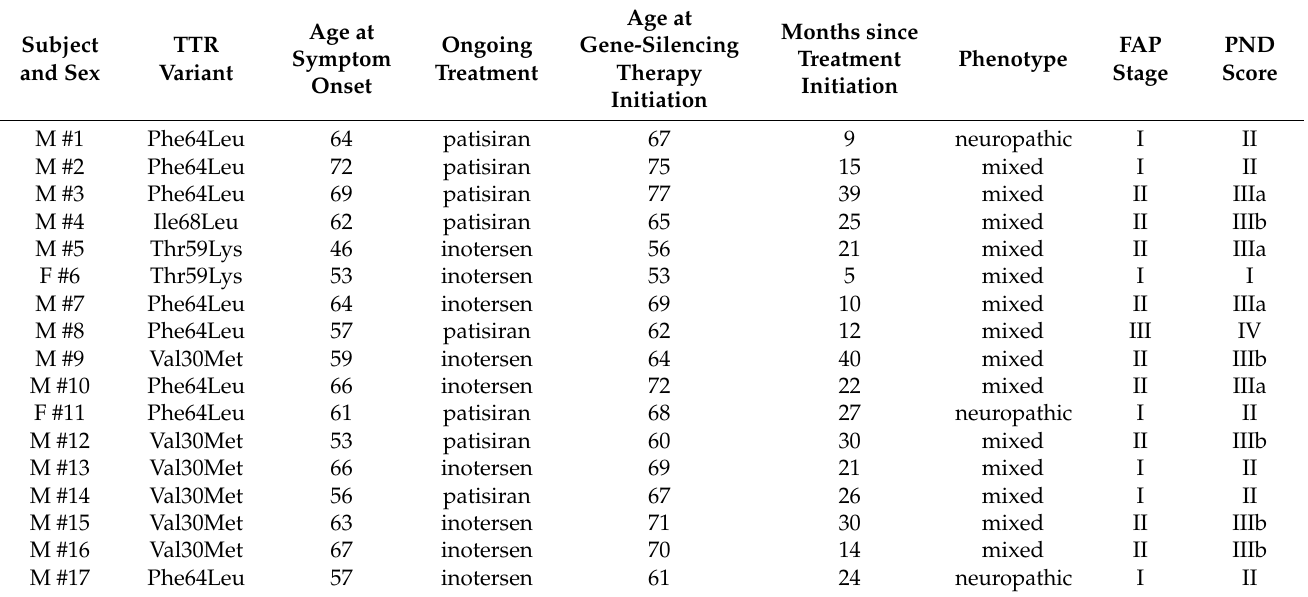
Table 2. Demographic and clinical data of the whole cohort of ATTRv patients. FAP, familial amyloid polyneuropathy. PND, polyneuropathy disability score. M, male. F, female.